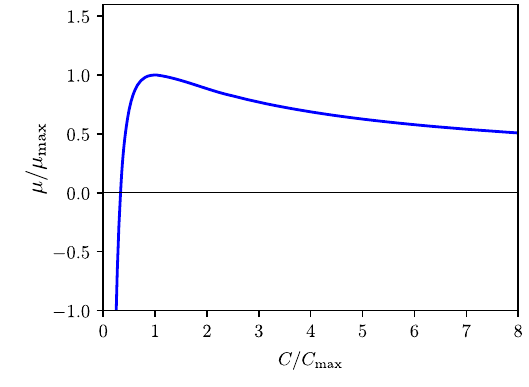
Fig. 5 μ − C curve at fixed ( S , J